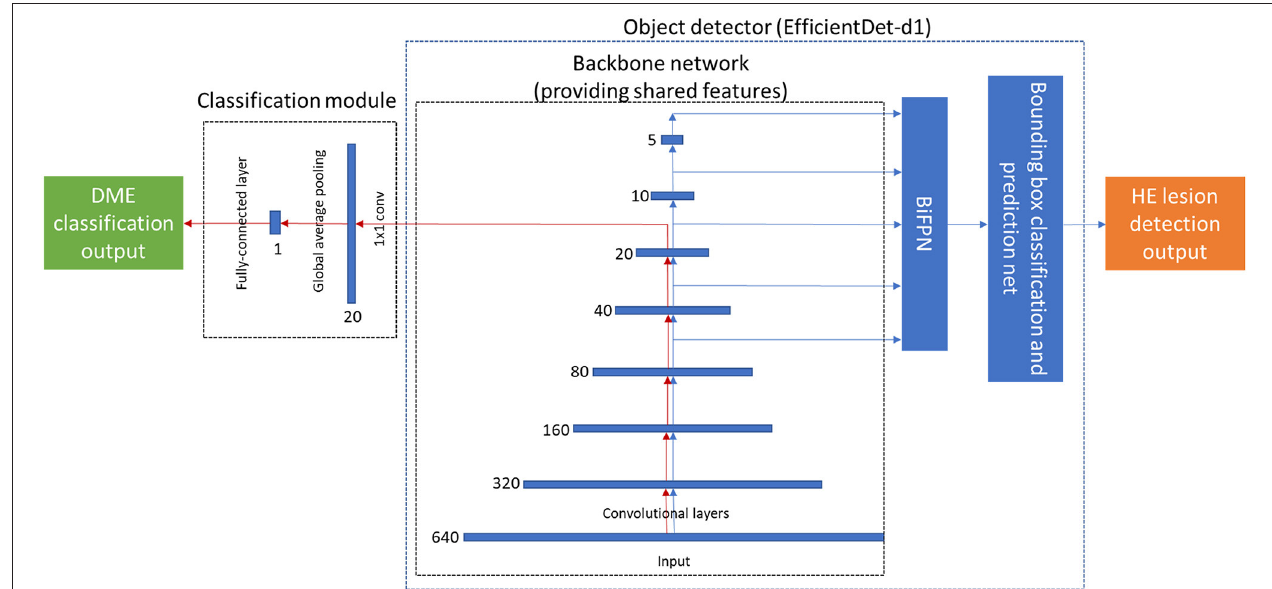
FIGURE 3 | The architecture of the proposed end-to-end deep fusion model. The red arrow denotes the classification path, which forms the same architecture as EfficientNet-b1. The blue arrow denotes the lesion detection path, which has the same architecture as EfficientDet-d1. The number (640, 320, 160, …) near each feature map denotes its resolution.